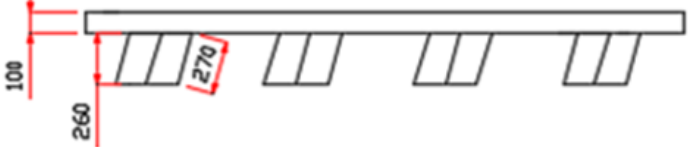
Figure 5. Gravity anchor shear key.